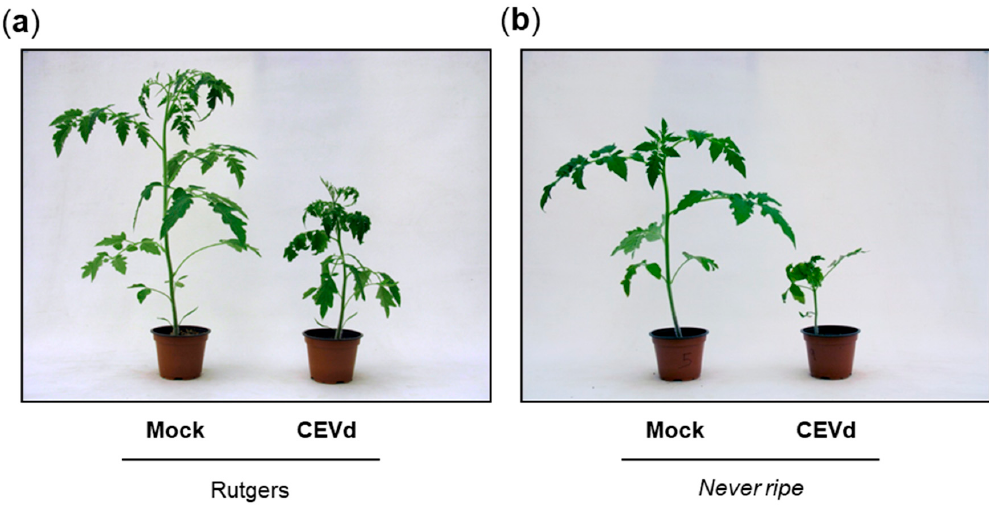
Figure 1. Symptomatology in Rutgers parental and Never ripe tomato plants at 20 days after citrus exocortis viroid (CEVd) inoculation. Representative phenotype observed in ( a ) wild type Rutgers plants and ( b ) Never ripe mutants.